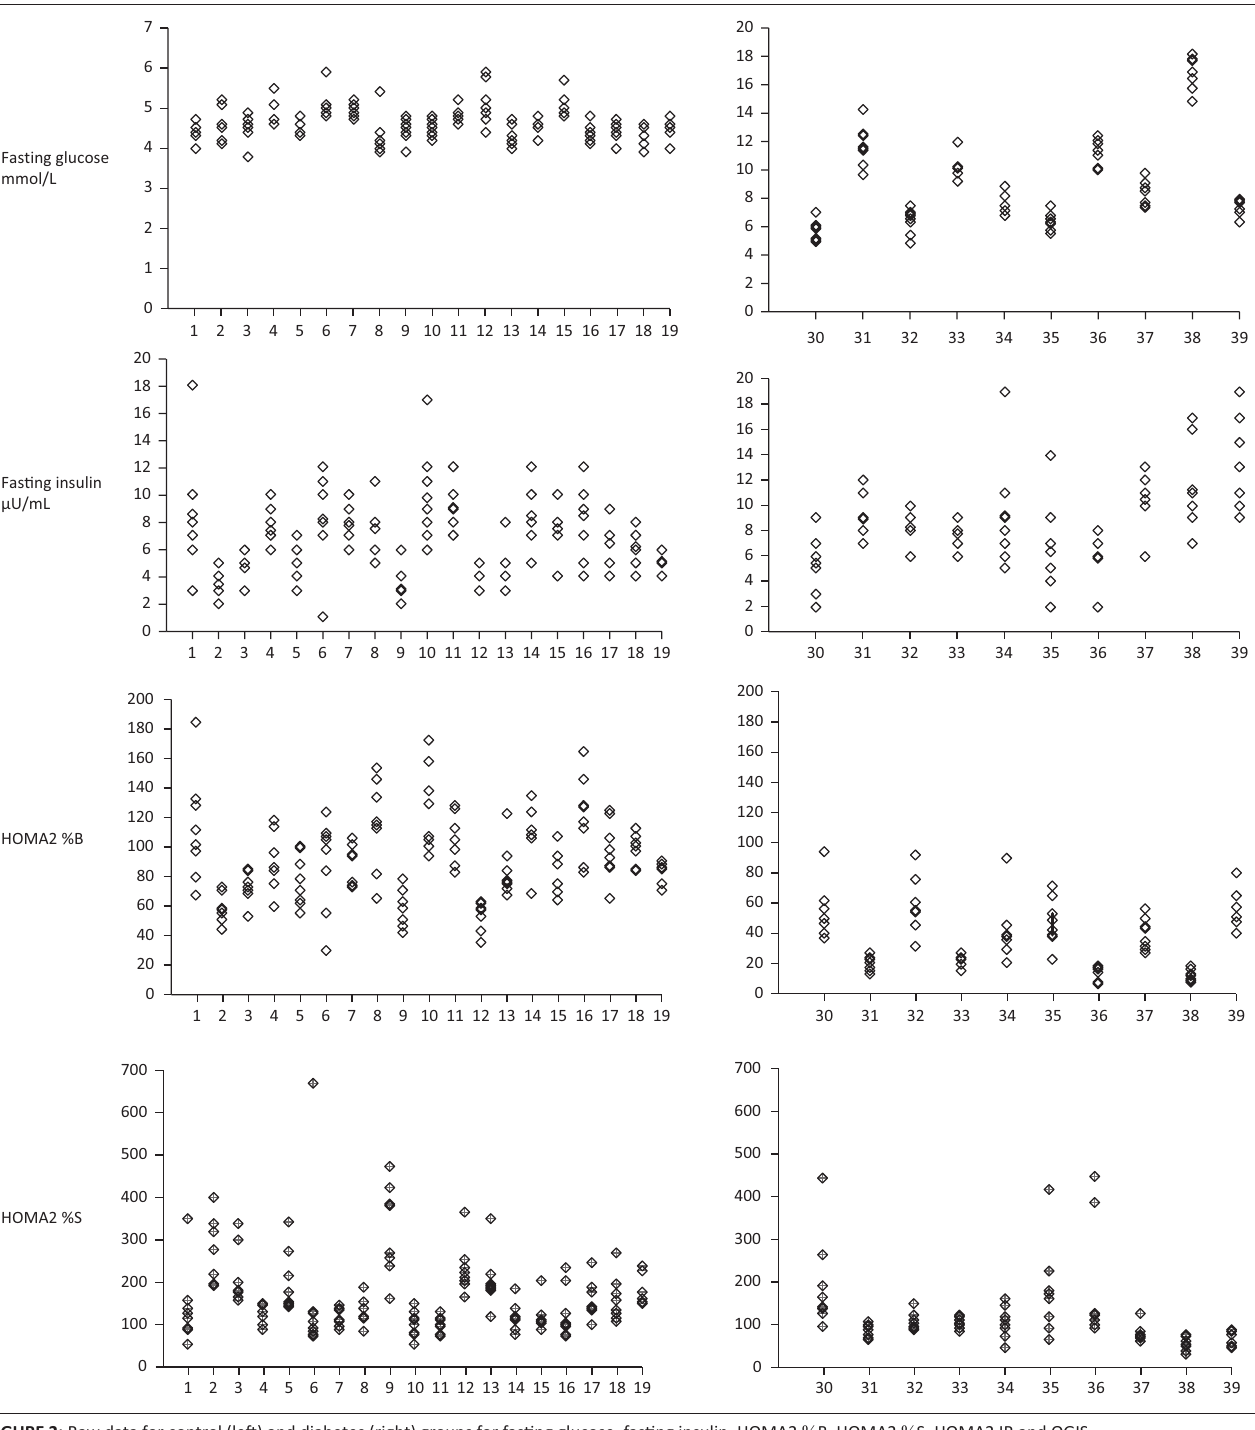
FIGURE 2: Raw data for control (left) and diabetes (right) groups for fasting glucose, fasting insulin, HOMA2 % B, HOMA2 % S, HOMA2 IR and